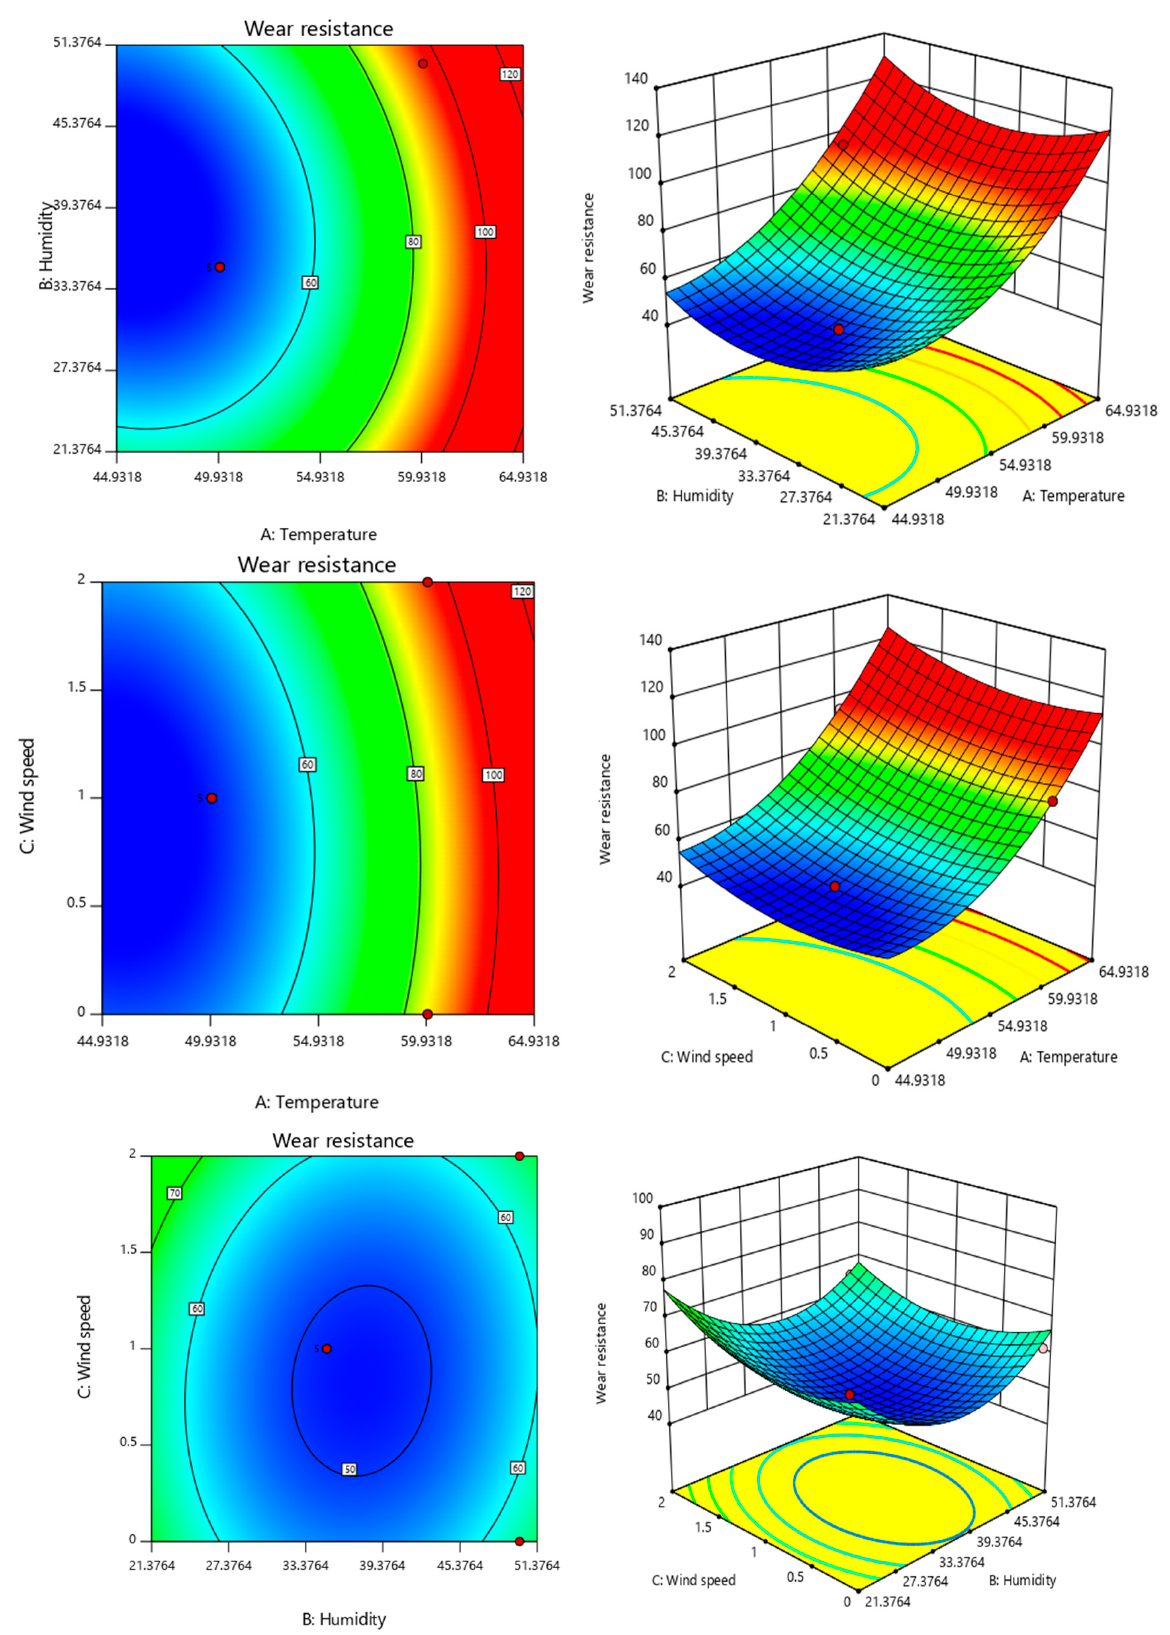
Figure 6. The response surface and contour of temperature, humidity and wind speed for the solid drying time. (Left is the response surface, right is the contour map).